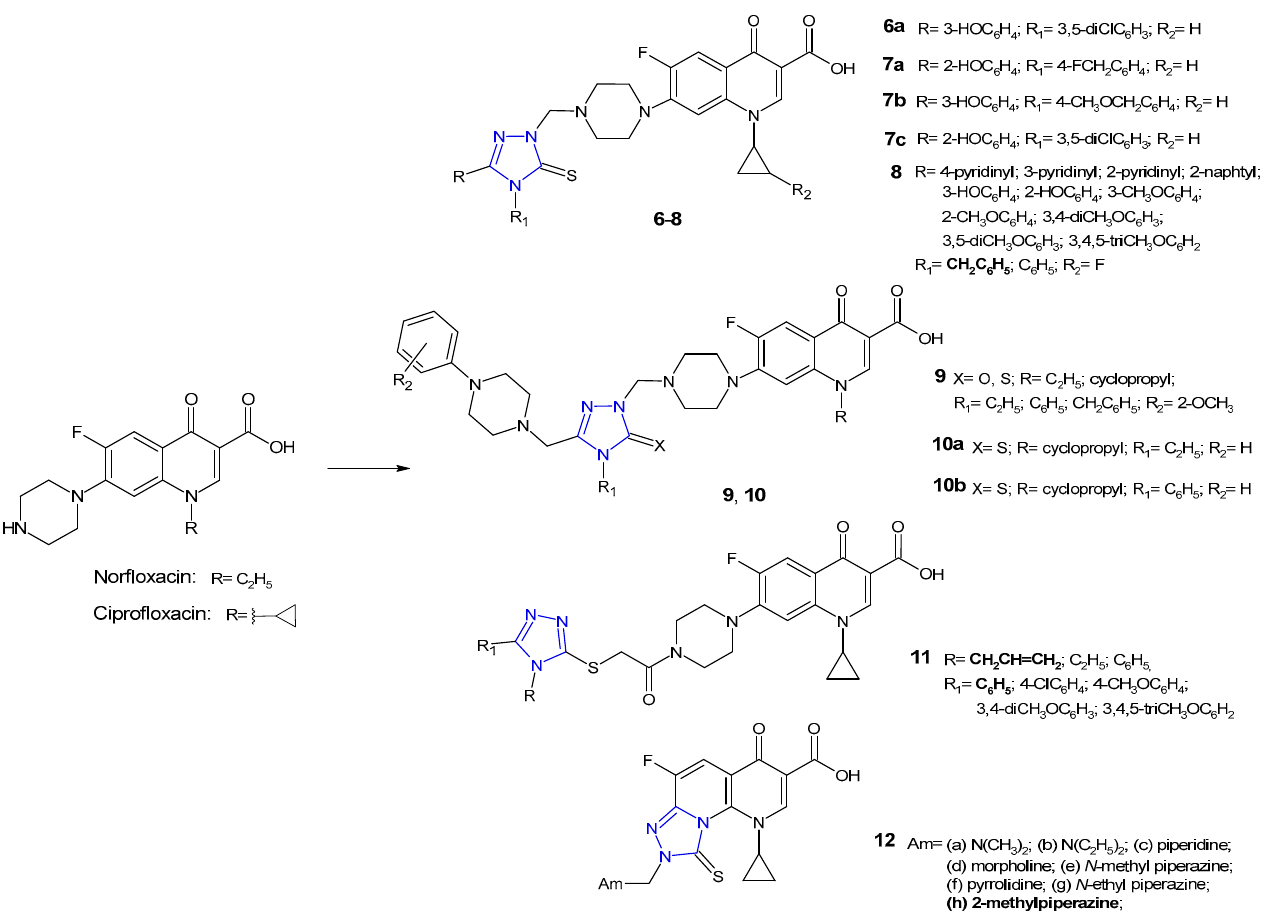
Figure 5. 1,2,4-triazole analogues of norfloxacin and ciprofloxacin. 1,2,4-Triazole hybrids of 1-[(1 R ,2 S )-2-fluorocyclopropyl]ciprofloxacin 8 (Figure